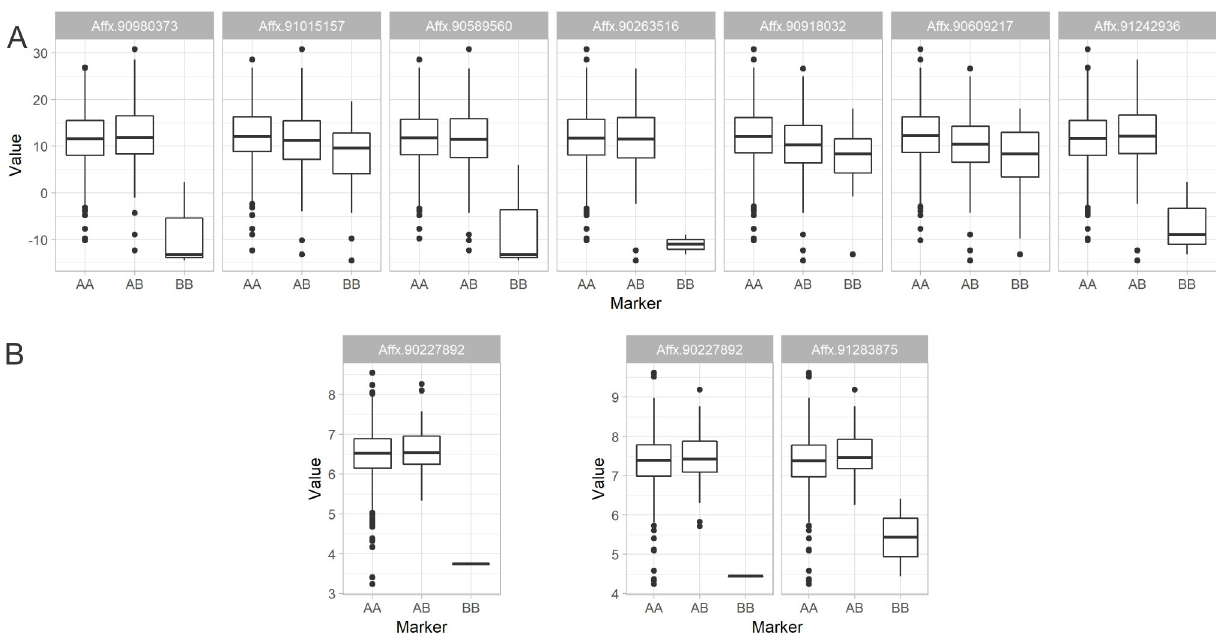
Fig 4. A) Boxplot of LNTI adjusted means (%) by genotypic classes for significant markers. Affx.90980373 was significant for both additive and dominance effects. Affx.91242936 was significant for dominance effect. All other markers were significant for the additive effect; B) Boxplot of GY LN (left) and GY IN (right) adjusted means (Mg ha -1 ) by genotypic classes for significant markers. Affx.91283875 was significant for dominance effect. Affx.90227892 was significant for additive